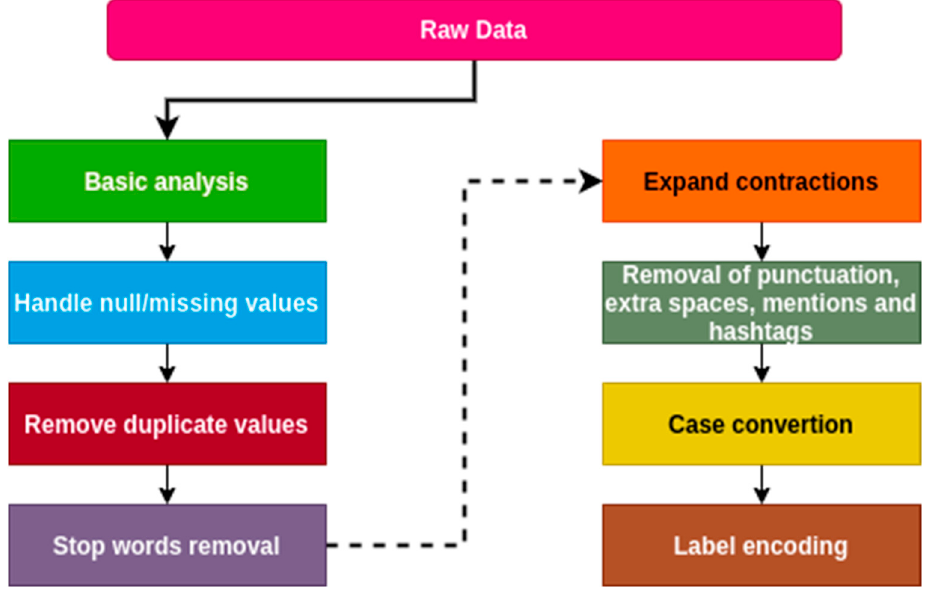
Figure 11. Dataset